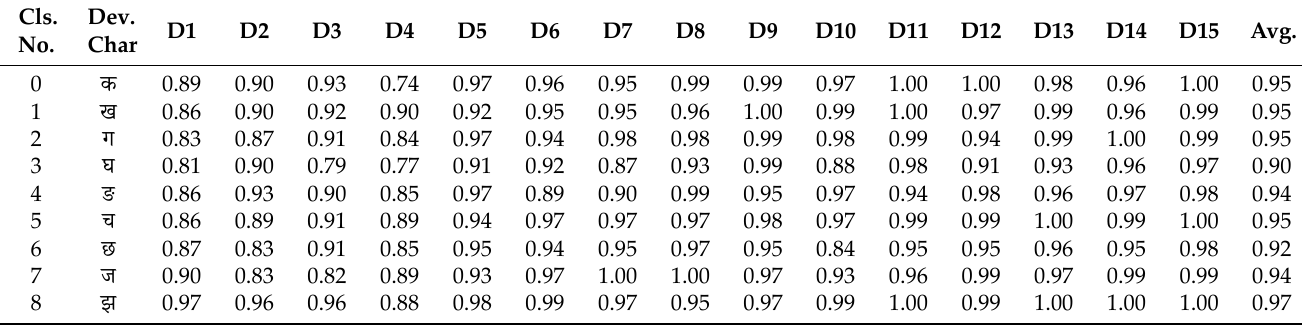
Table 8. Character‑wise recall produced by an MLP classifier for the proposed datasets.